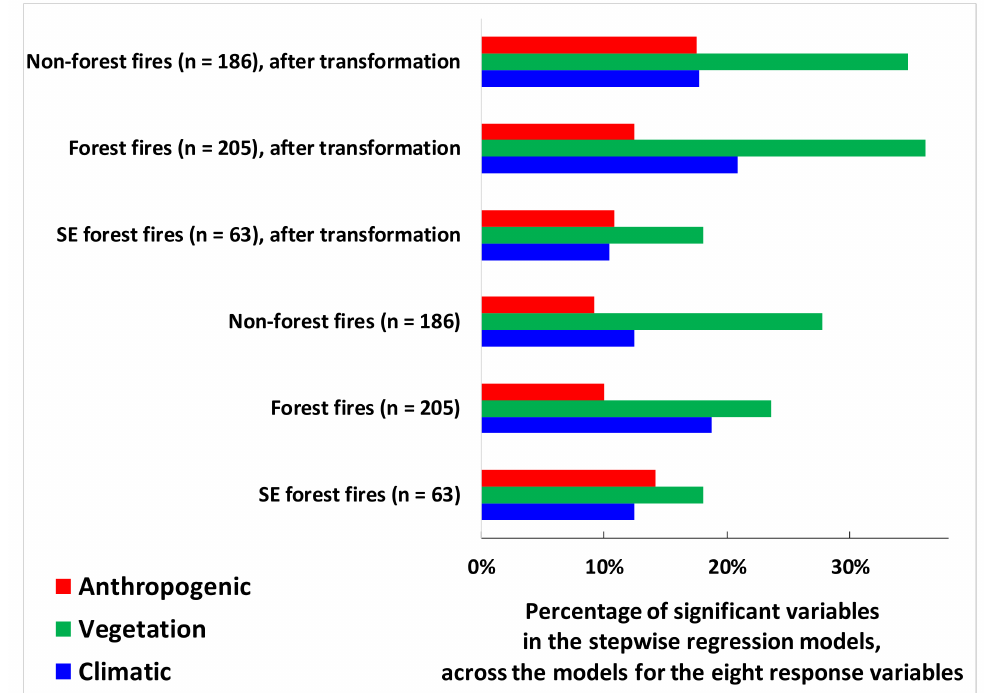
Figure 13. The percentage of explanatory variables (classified into anthropogenic, vegetation or climatic variables) entered into the stepwise regression models across all response variables for Black Summer non-forest fires ( n = 186), Black Summer forest fires ( n = 205) and Black Summer forest fires in SE Australia ( n =